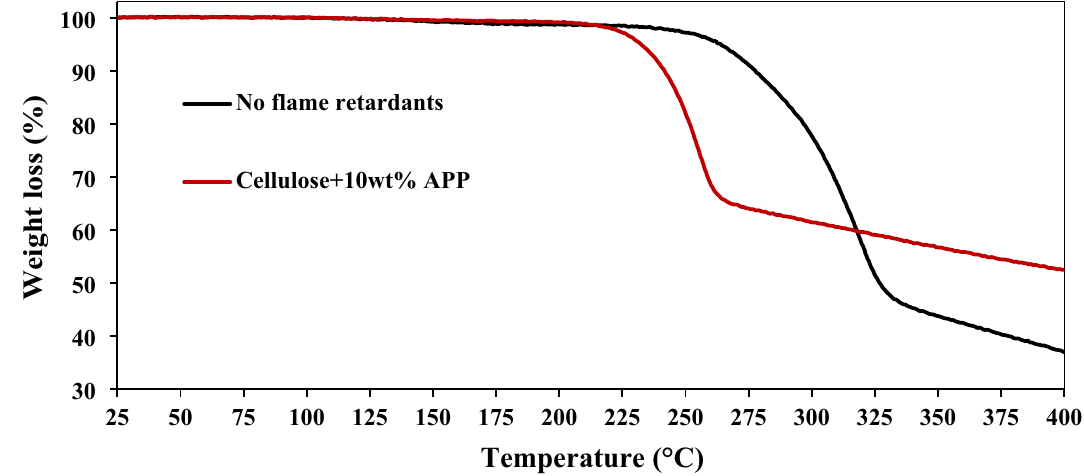
Figure 1. TGA analysis on cellulose-APP composites with 10 wt% APP under air at 5 °C/min.